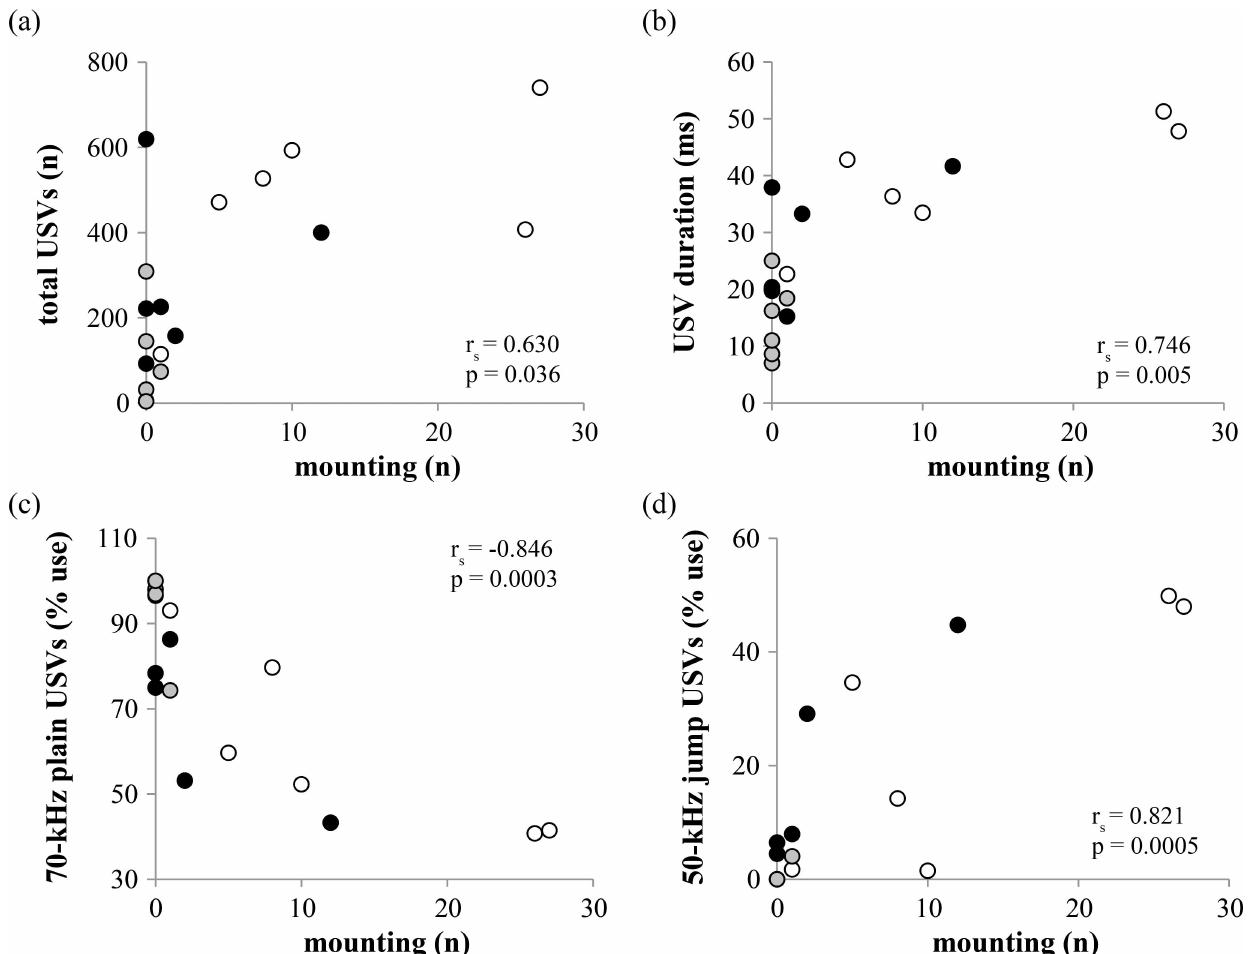
Fig 7. Mounting behavior is correlatedwith several aspects of ultrasonic vocalizations emitted by pairs of male mice with different social histories. (a) Mountingversus total ultrasonic vocalizations (USVs). (b) Mountingversus USV duration. (c) Mountingversus proportional use of 70-kHz plain USVs. (d) Mountingversus proportional use of 50-kHz jump USVs. Black circles: IND-IND pairs; white circles: IND-SOC pairs; gray circles: SOC-SOC pairs. IND = individuallyhoused male; SOC = sociallyhoused male. See methods for additionaldetailsregarding